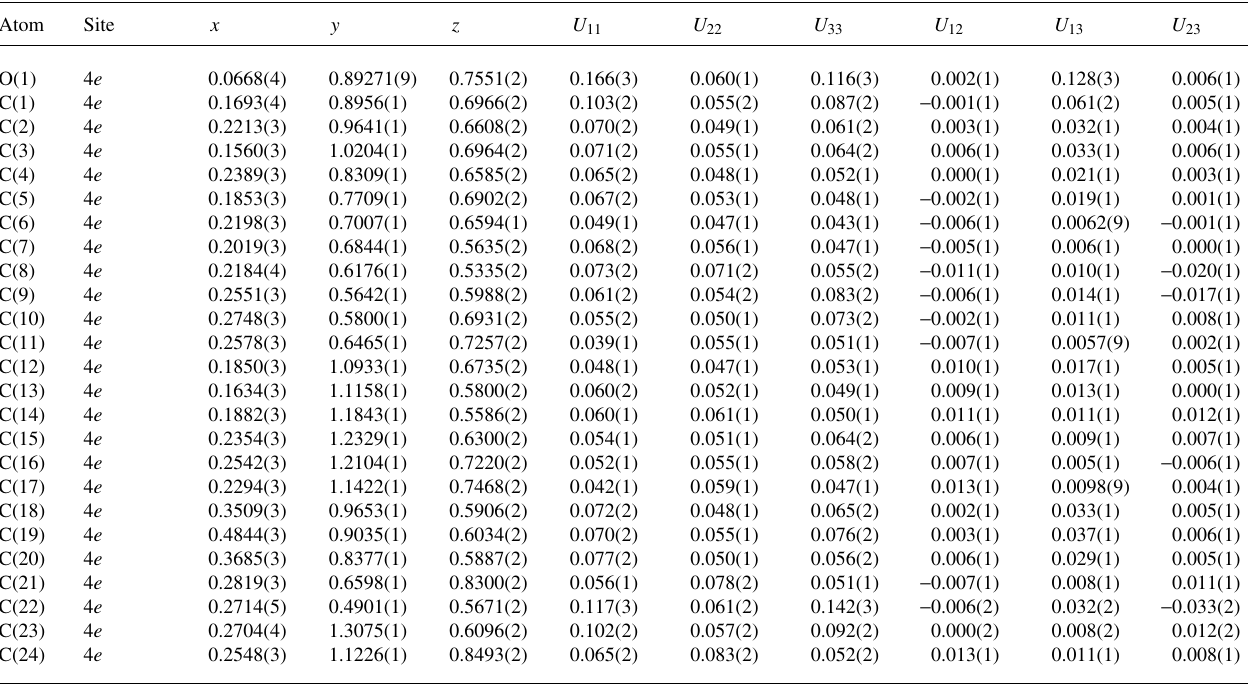
Table 3. Atomic coordinates and displacement parameters (in Å 2 ) .